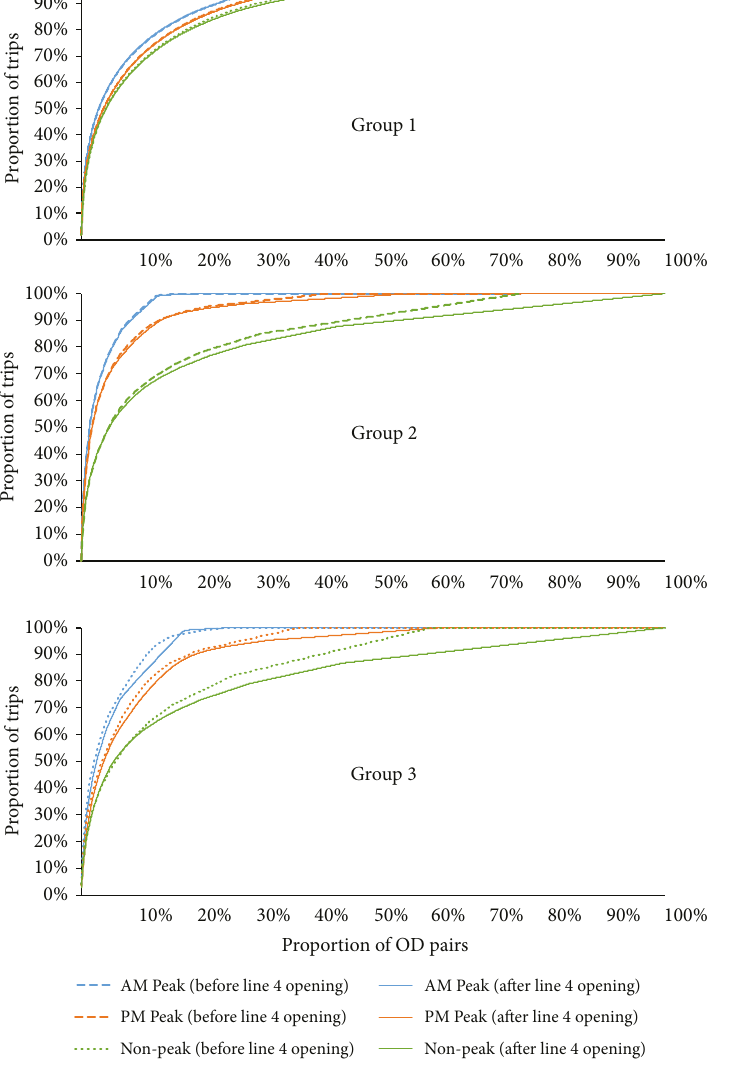
Figure 9: Cumulative number of trips with regard to proportion of ODs before and after Line 4 opening.